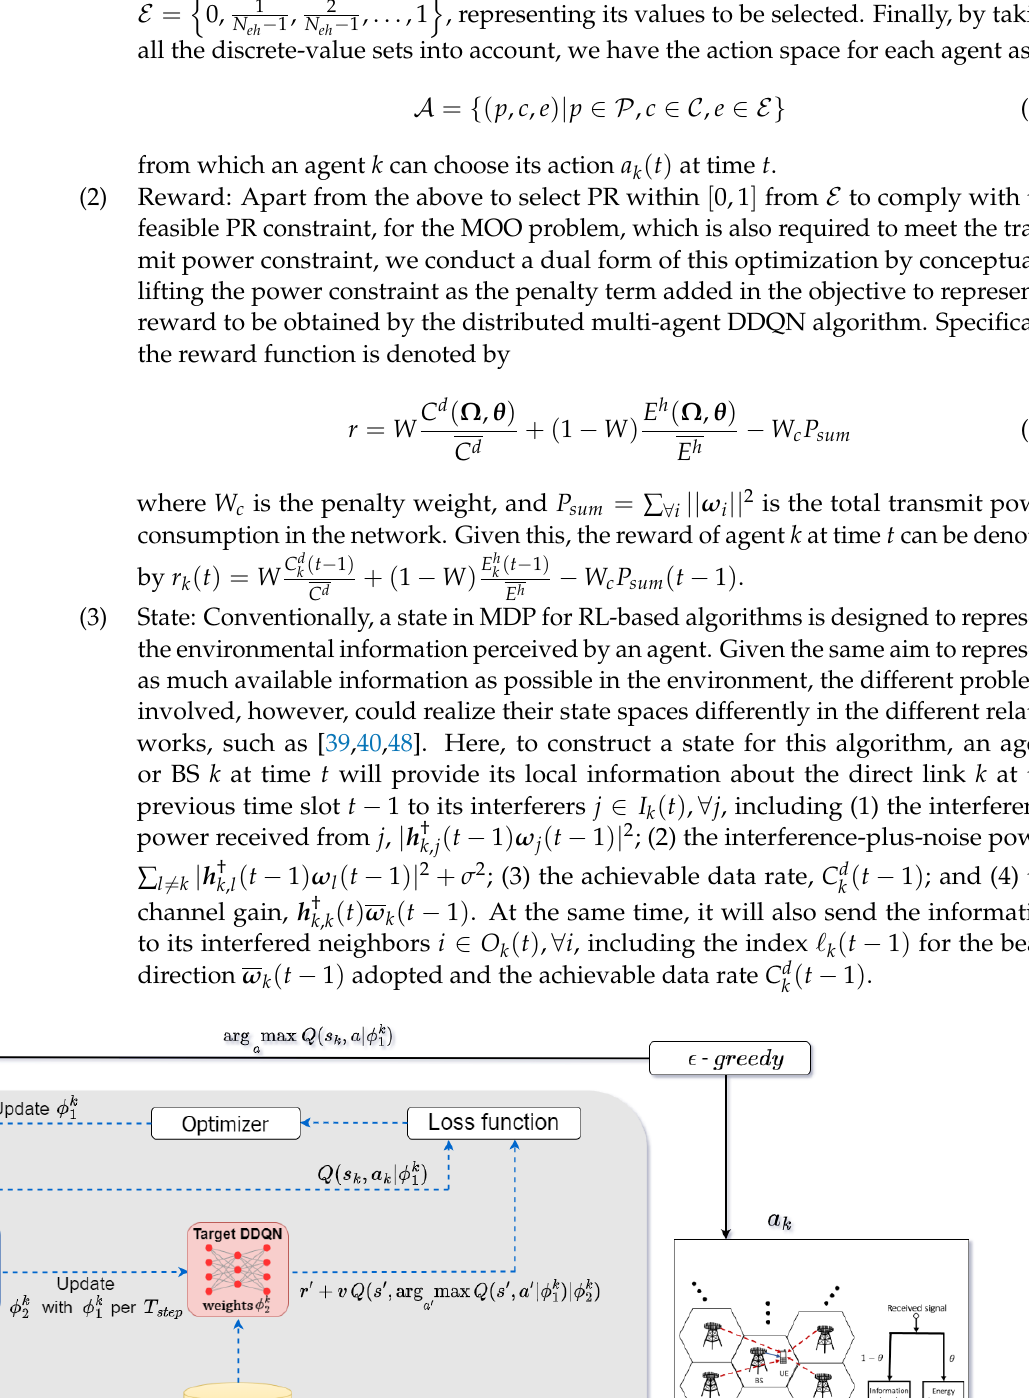
ω j ( t − 1 ) and the achievable data rate C d